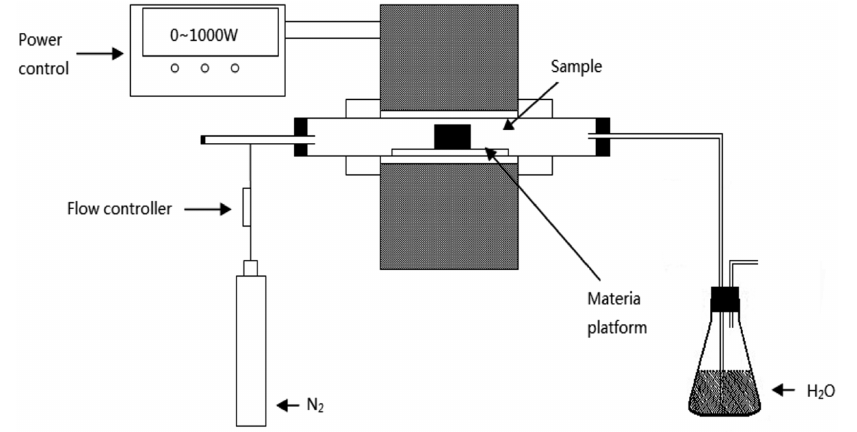
Figure 1: Schematic of microwave heat- ing furnace.